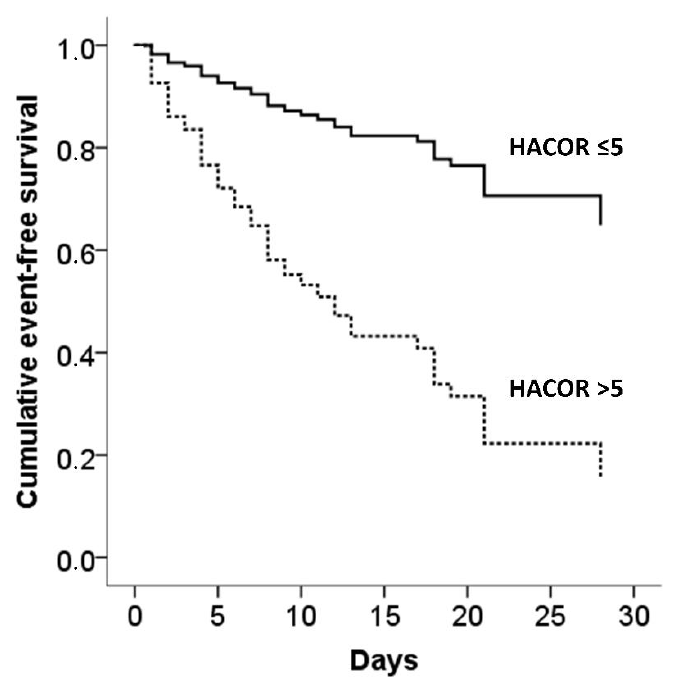
Figure 2. Adjusted event-free survival (need for intubation/in-hospital death) according to baseline HACOR score in the entire population.